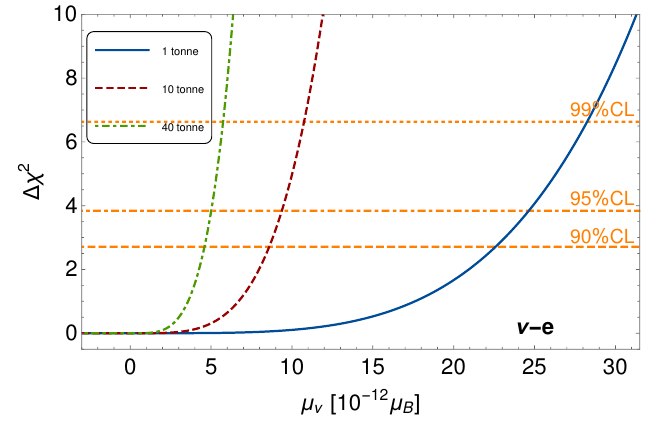
Figure 4 . Electron recoil sensitivities to neutrino magnetic dipole moments in 1, 10 and 40 tonne active volume detectors during a one-year data taking. The result assumes a 0 . 3 keV threshold, 100% detector efficiency and backgrounds for XENON1T, XENONnT and DARWIN as given in refs. [2, 22, 28]. The result is rather insensitive to threshold shifts (0.1 keV to 1